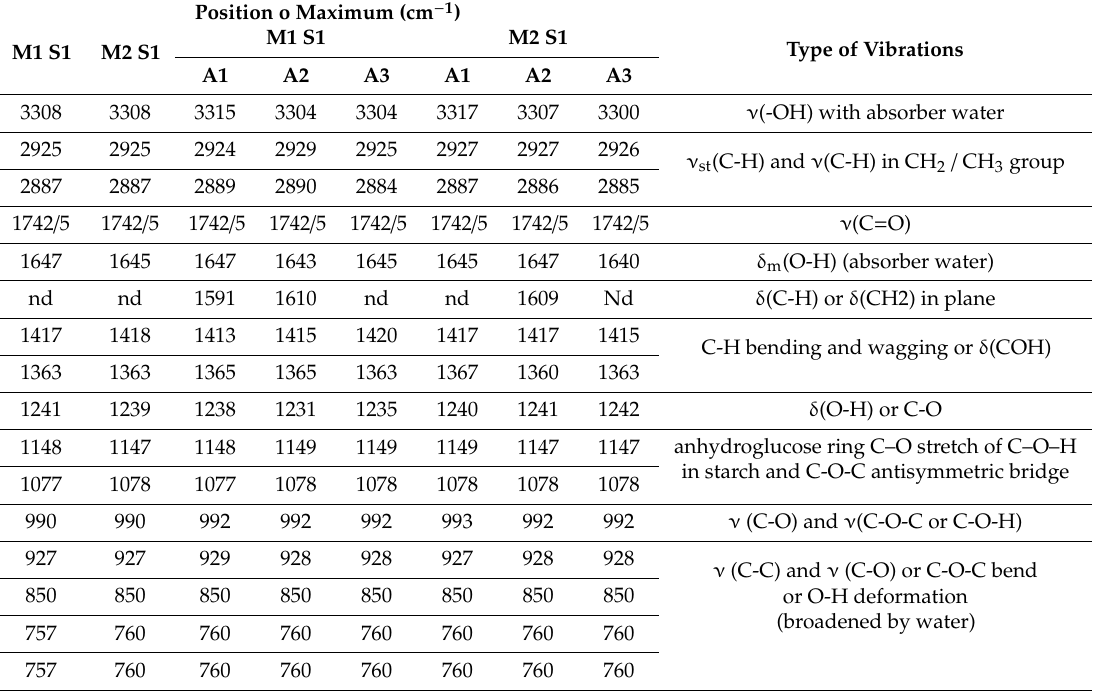
Table 6. Location of peaks of FTIR absorption spectra with the corresponding vibrations for materials selected for tests (biodegradable) over the 3800–550 cm − 1 spectrum